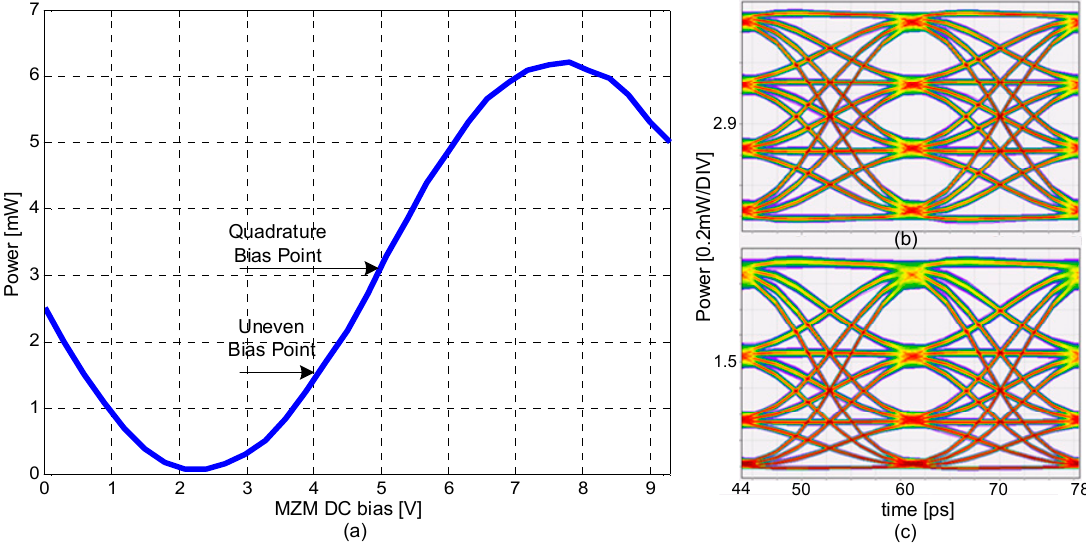
Figure 2. Eye diagrams at the optical transmitter output: ( a ) L/V curve of MZM; ( b ) even PAM at quadrature bias point of 5 V; ( c ) uneven PAM at bias point of 4.1 V.